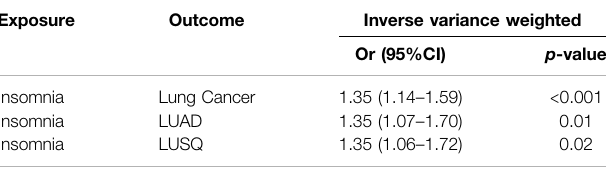
( Supplementary Table S2 ; Supplementary Figure S2 )